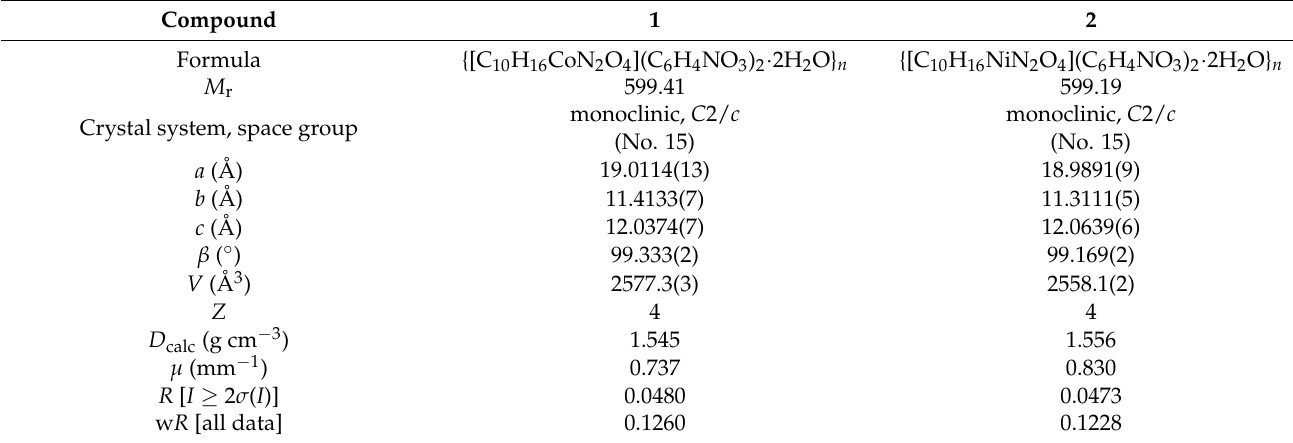
The crystallographic data for {[Co(4,4 (cid:48) -bpy)(H 2 O) 4 ](6-OHnic) 2 · 2H 2 O} n ( 1 ) and {[Ni(4,4 (cid:48) -bpy)(H 2 O) 4 ](6- Onic) 2 · 2H 2 O} n ( 2